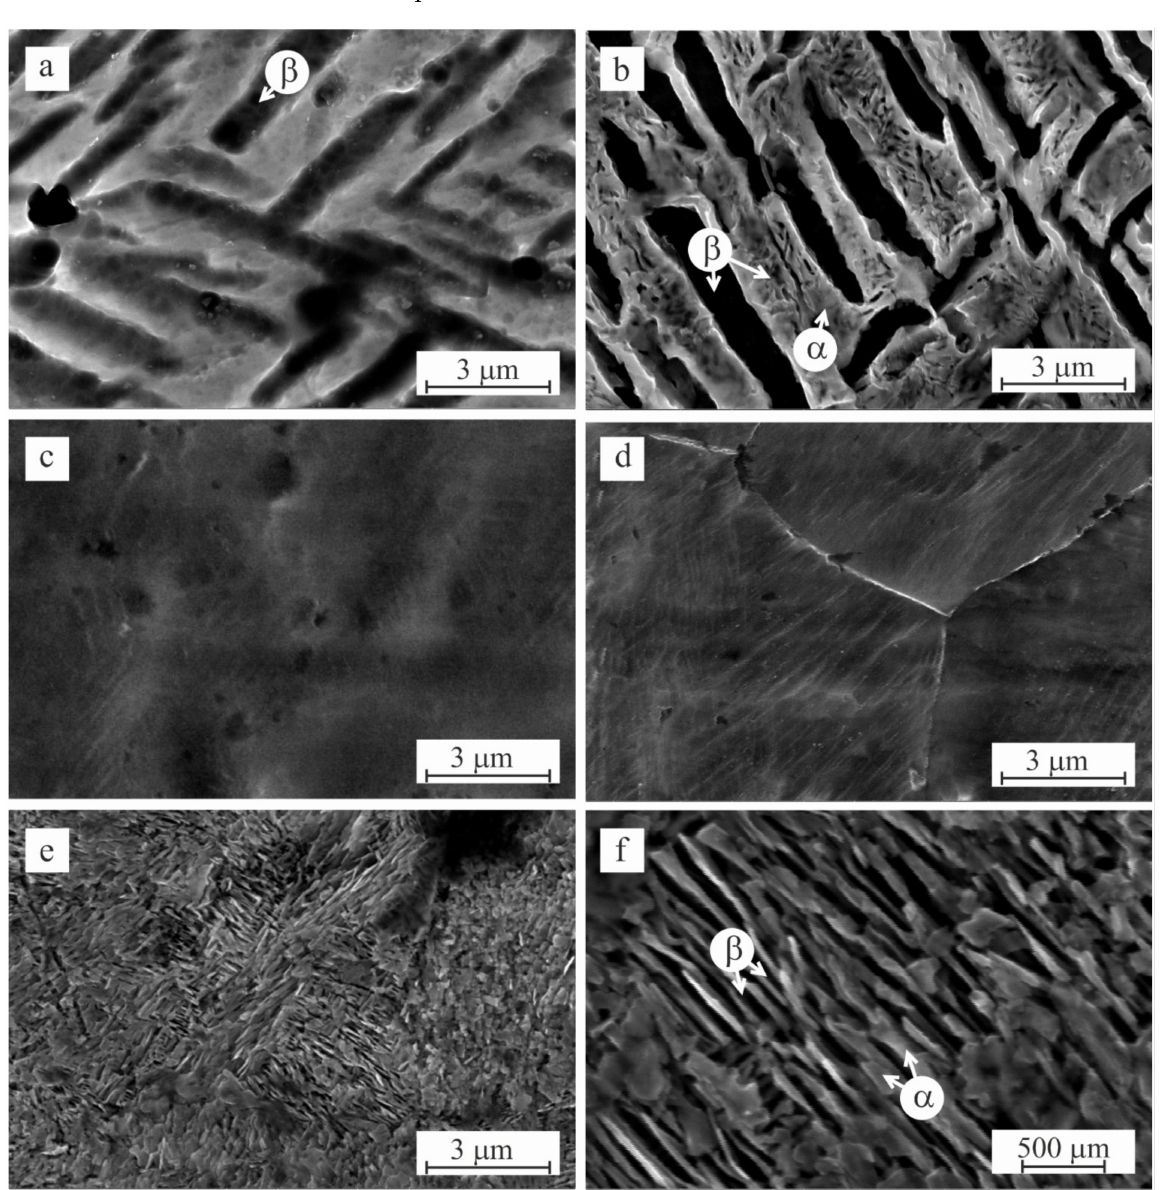
Figure 4. Microstructure of the α + β titanium alloy after EMT: ( a )—after EMT with j = 300 A/mm 2 ; ( b )—after EMT with j = 300 A/mm 2 + aging at 600 ◦ C for 14 h; ( c , d )—after EMT with j = 600 A/mm 2 ; ( e , f )—after EMT with j = 600 A/mm 2 + aging at 600 ◦ C for 14